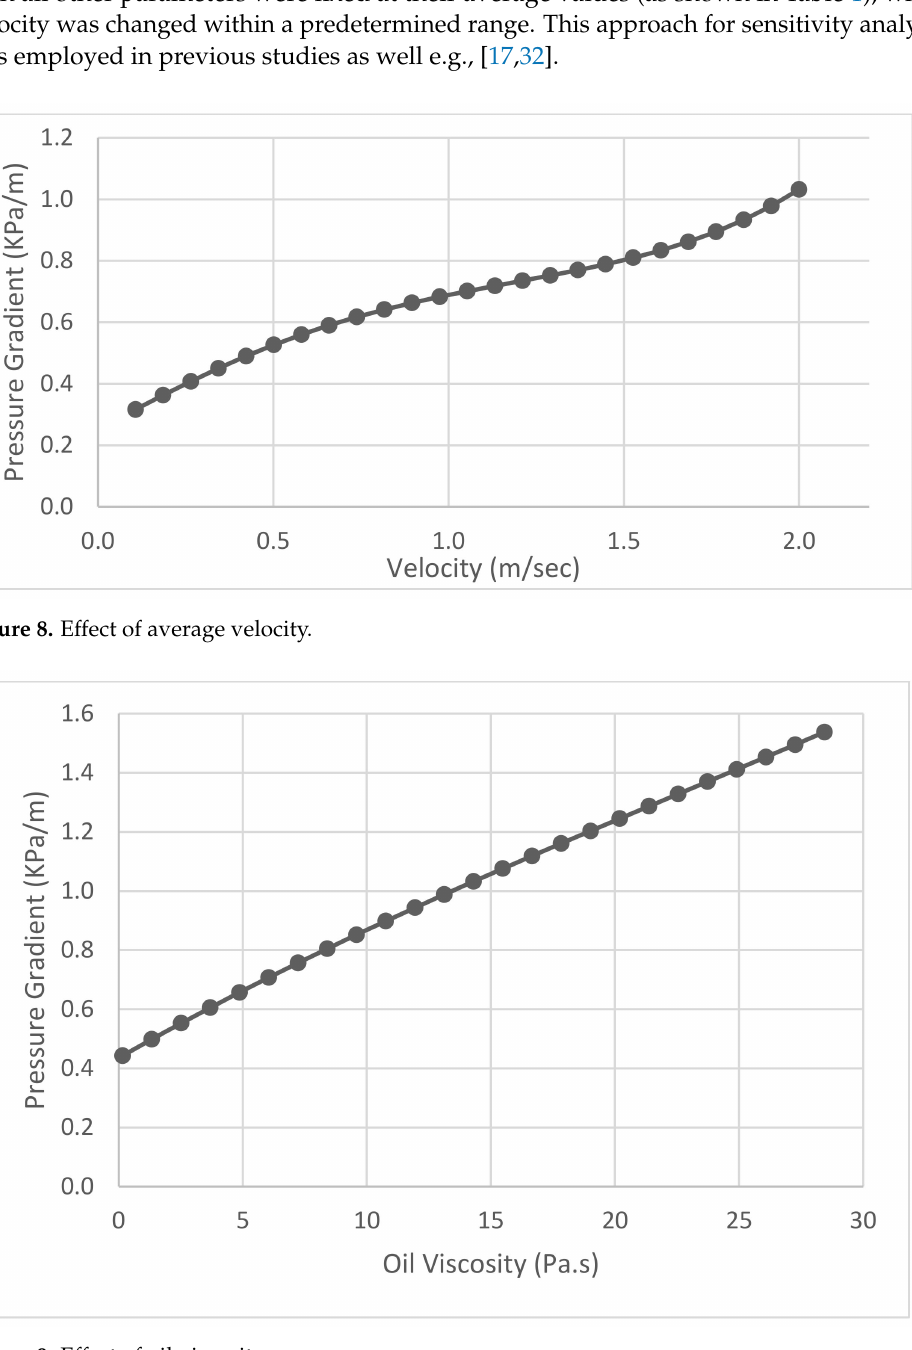
Figure 9. Effect of oil